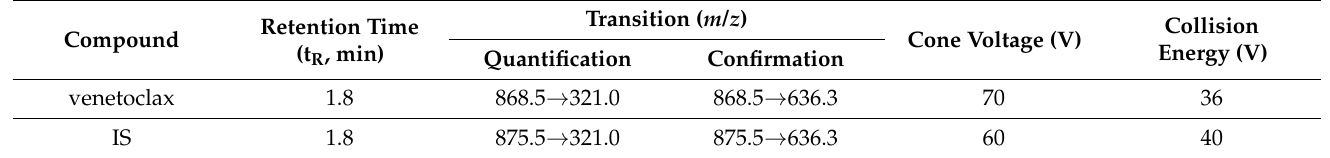
Table 1. Relevant LC–MS/MS characteristics. internal standard, IS.